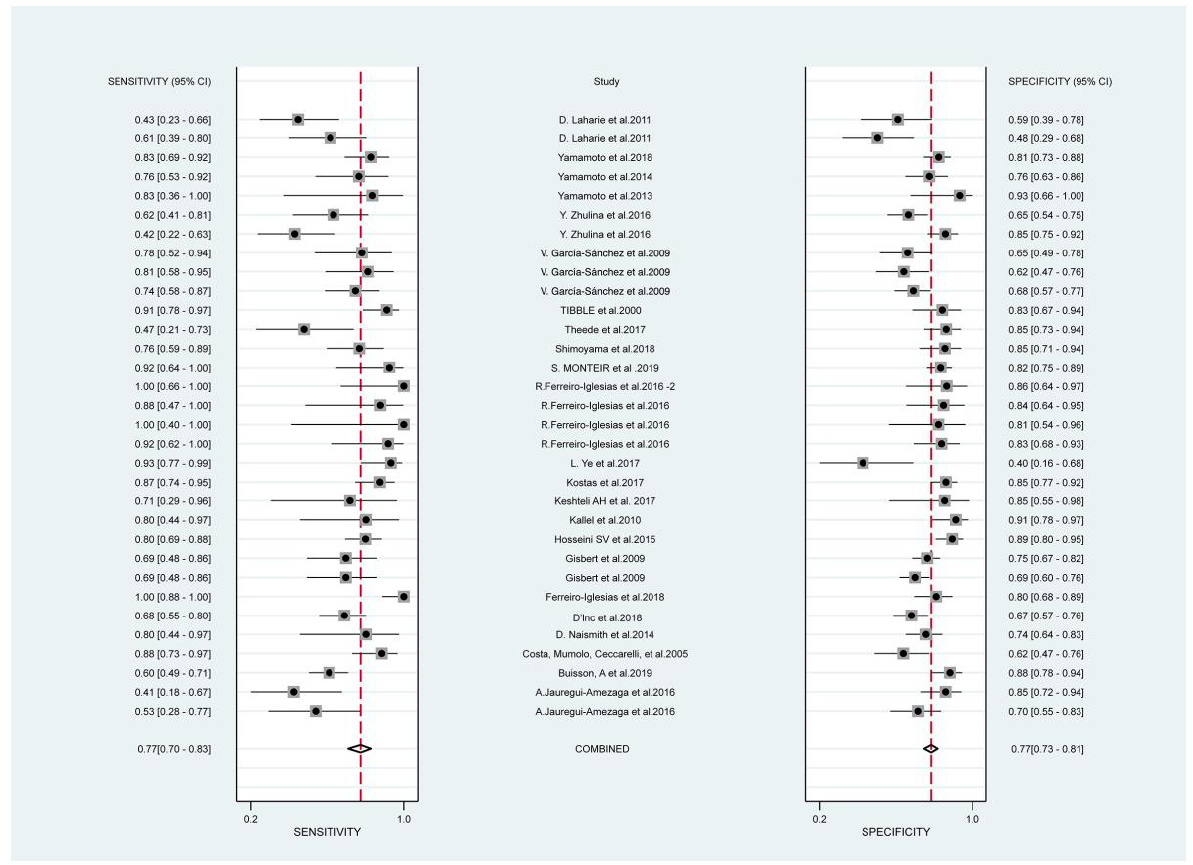
Figure 2. Forest plots of pooled sensitivity and 1 − specificity of Fecal Calprotectin at remission for predicting relapse in inflammatory bowel disease. Plots display diagnostic probabilities of included studies and their corresponding 95% confidence intervals [7,40–62].